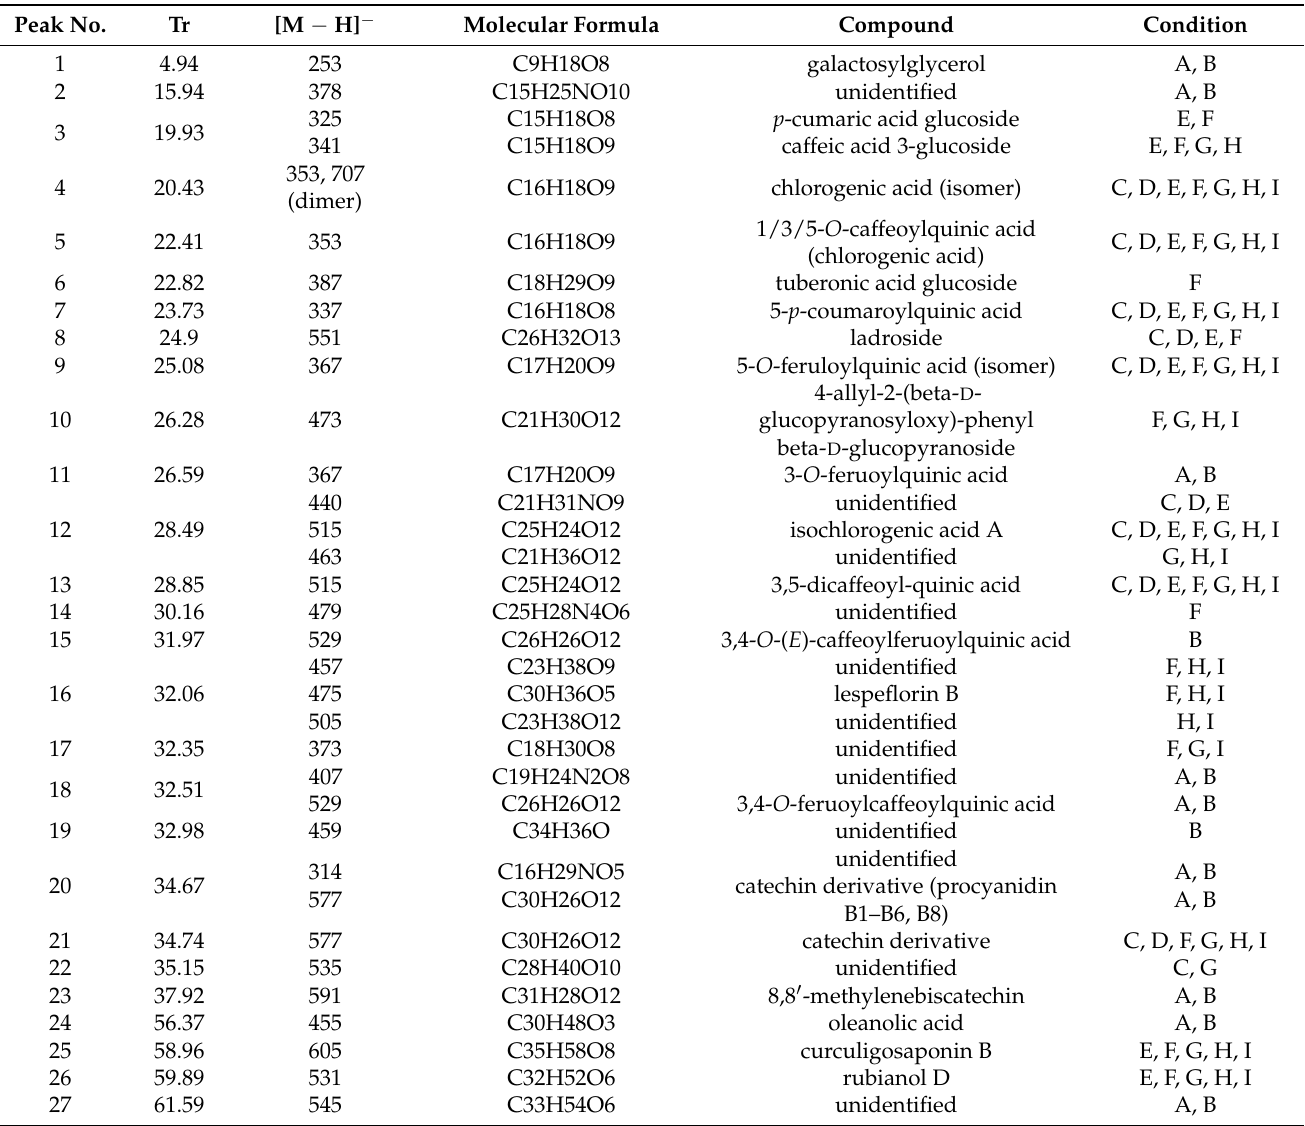
Table 3. HPLC-PDA-ESI-MS data on detected compounds in hairy root extracts derived from various